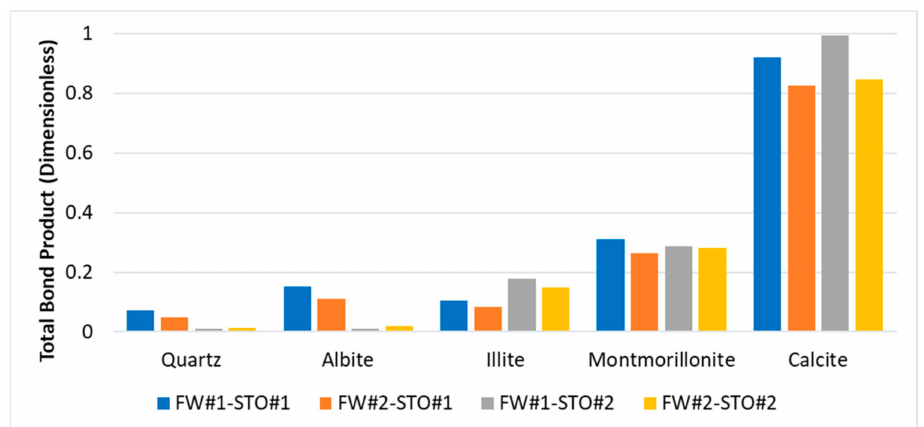
Figure 2. Total bond product (oil adhesion tendency) of minerals during FWI.